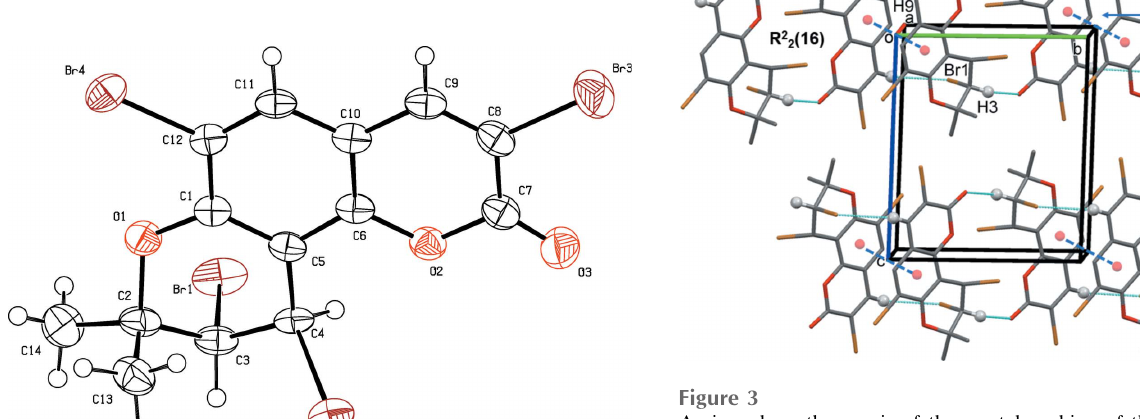
(16) ring motifs 2